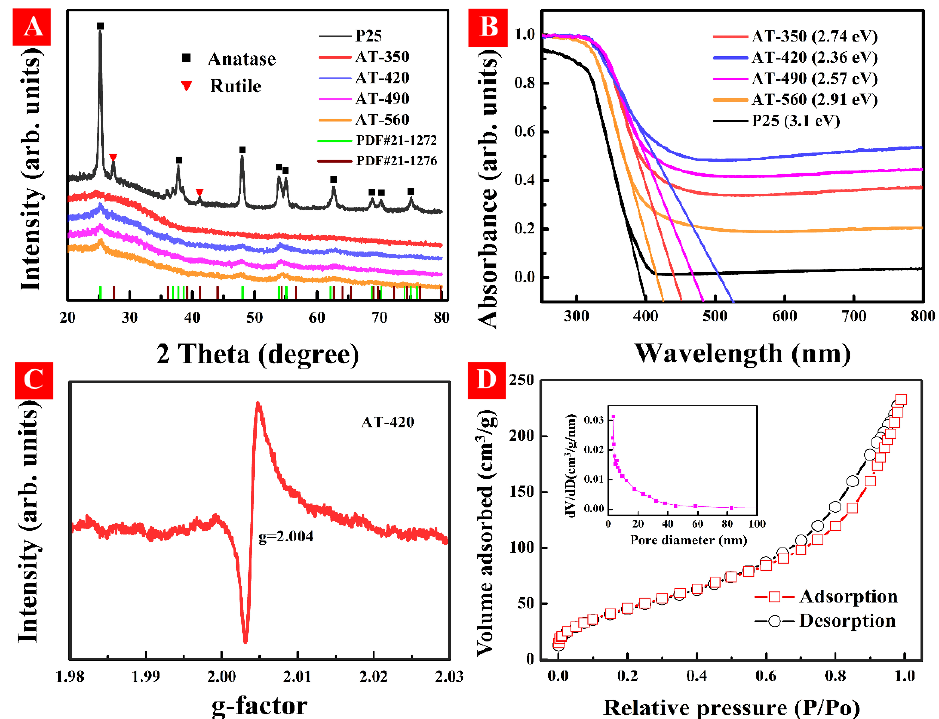
Figure 2. ( A ) The X-ray diffraction (XRD) patterns and ( B ) UV-vis diffuse-reflectance spectra for all as-prepared samples. ( C ) EPR spectrum and ( D ) nitrogen adsorption-desorption isotherms of AT- 420 sample, inset is the pore diameter distribution calculated by the BJH